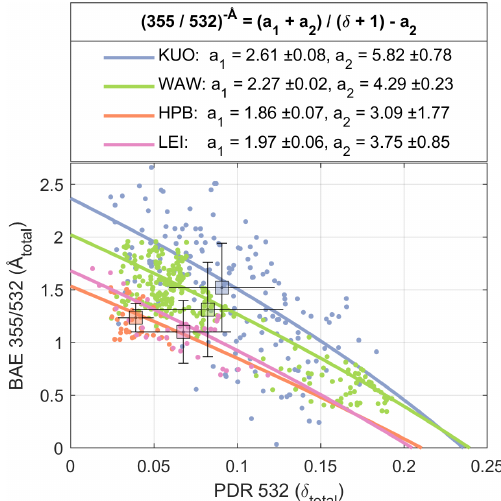
Figure 2. Relationships of the particle linear depolarization ra- tio (PDR, δ ) at 532nm and the backscatter-related Ångström ex- ponent (BAE, Å ) between 355 and 532nm. All bins inside pollen layers are shown by dots for each station with different colours. Averaged layer-mean values are given by the square, with the vari- abilities shown by bars. Fitting regression lines (Eqs. 7 and 9) are drawn with parameter values given in the